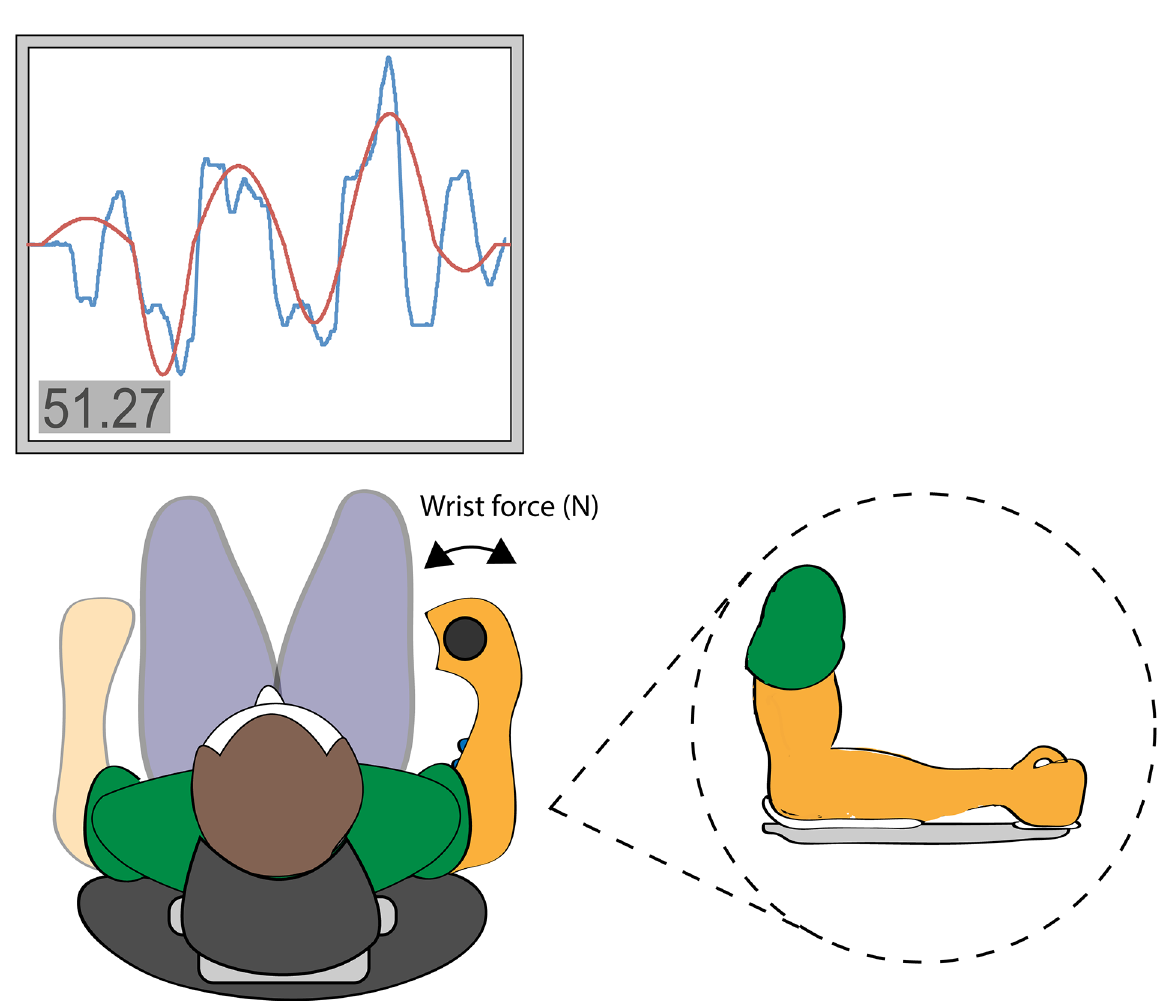
Fig 1. The visuomotor accuracy tracking task (VAT). Illustration of the setup for the visuomotor accuracy tracking task